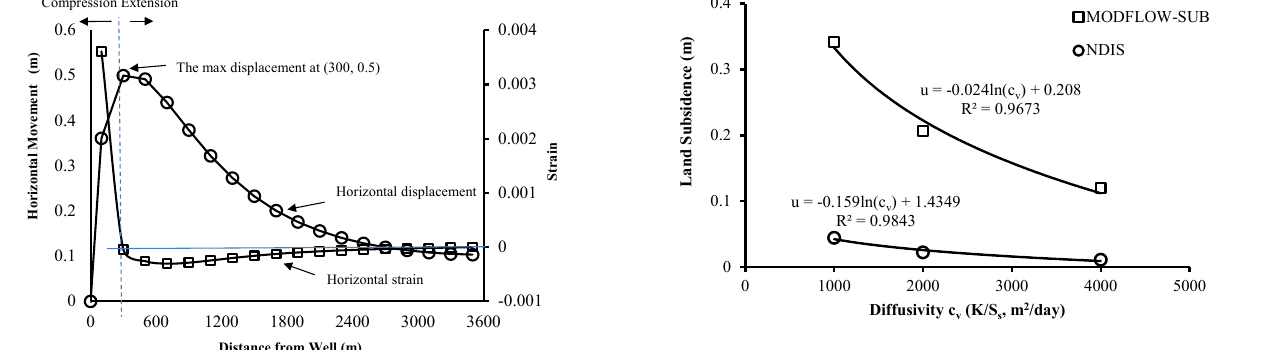
Figure 7. Comparison between NDIS and MODFLOW-SUB mod- els for subsidence sensitivity to hydraulic diffusivity, c v is diffusiv- ity ( = K/S s , m 2 day − 1